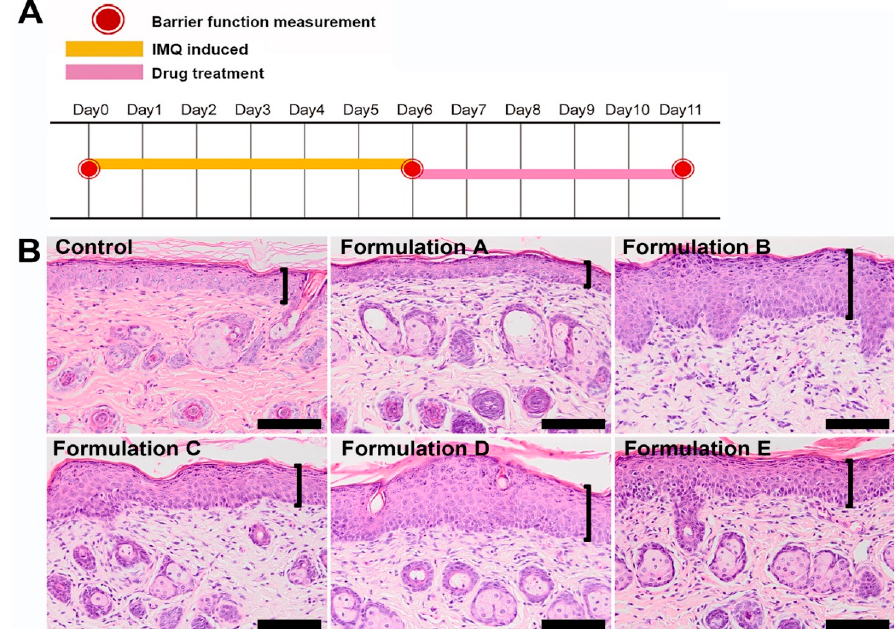
Figure 2. Selection of the topical delivery carrier for Sal. B. ( A ) To select the suitable formulation for inflammatory skin disease, the skin-irritation study was conducted by imiquimod (IMQ)-induced psoriasis-like dermatitis model. ( B ) The histopathological results showed that the formulation A treatment group had similar pathological features as the control group with less skin irritation than all the other groups; therefore, formulation A was selected for further studies. Scale bar = 100 µ m. Brackets indicate thickness of